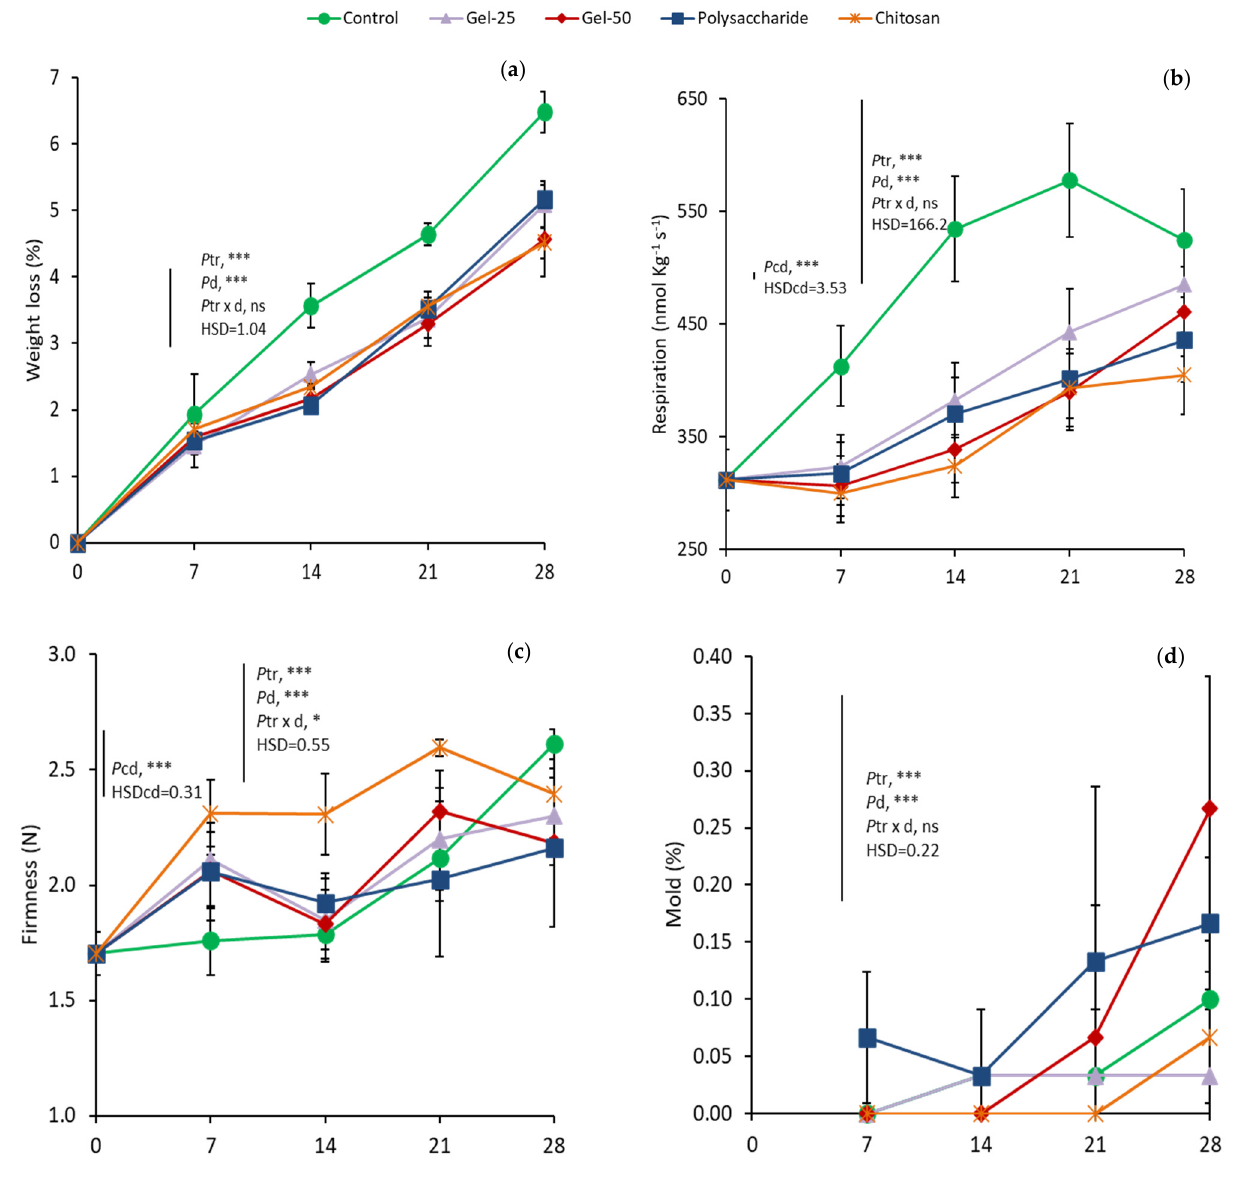
Figure 3. Effect of edible coatings on changes in weight loss (WL) ( a ), respiration ( b ), firmness ( c ) and microbial decay ( d ) in cherries during storage. Points are means of three replicates of 10 cherries each; bars on the points, ± standard deviations. NS, non significant; * significant at p < 0.05; *** significant at p < 0.001. Pcd , probability of storage days in controls (one-way ANOVA from day 0); HSDcd, honest significant difference calculated from ANOVA. Ptr , probability of edible coating treatment; Pd , probability of storage days; Ptr × d , probability of interaction (two-way ANOVA from day 7); HSD, honest significant difference calculated from ANOVA.